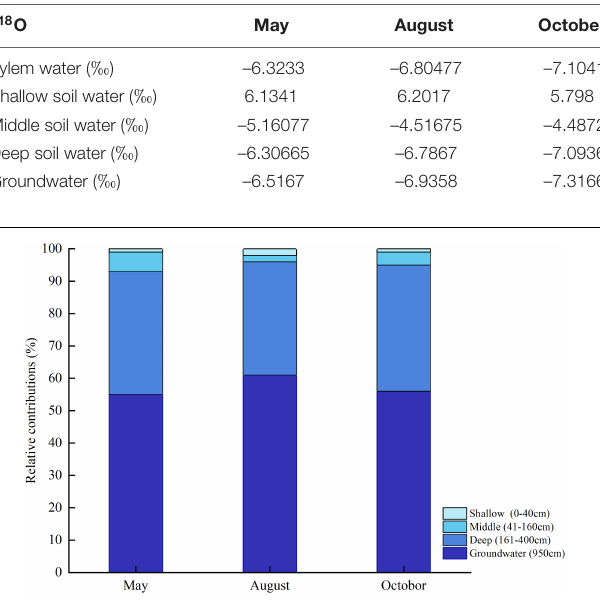
TABLE 2 | The oxygen isotopic values for xylem and potential water sources.